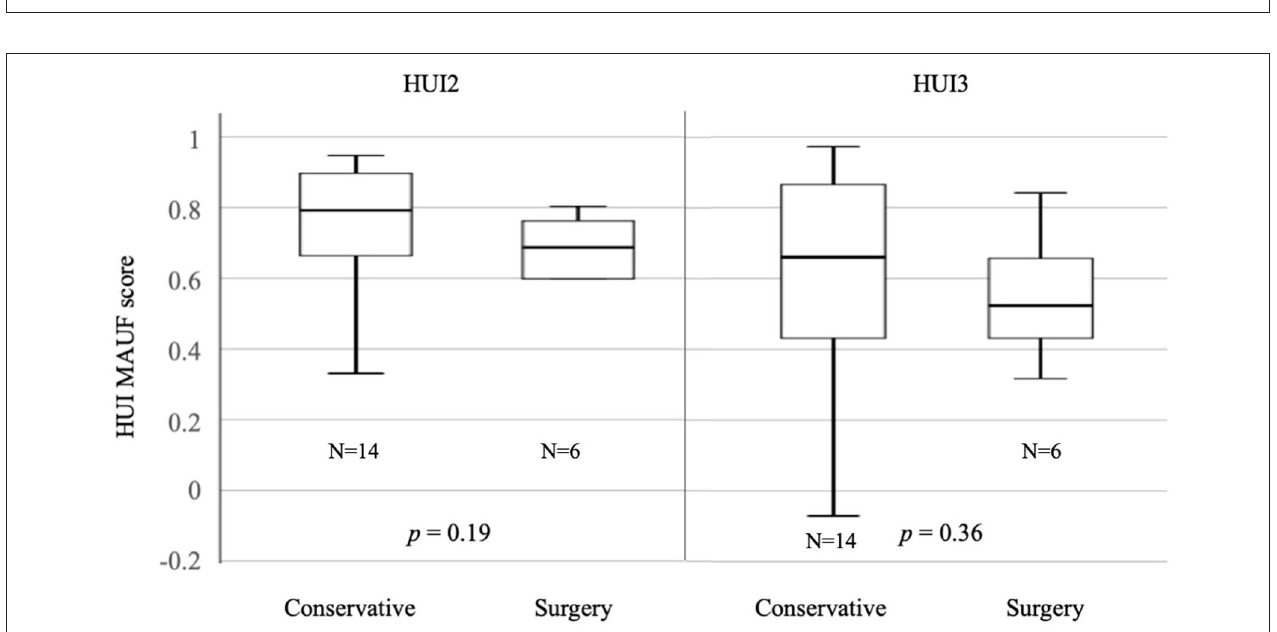
FIGURE 4 | Median HUI2 MAUF scores for conservative vs. surgical